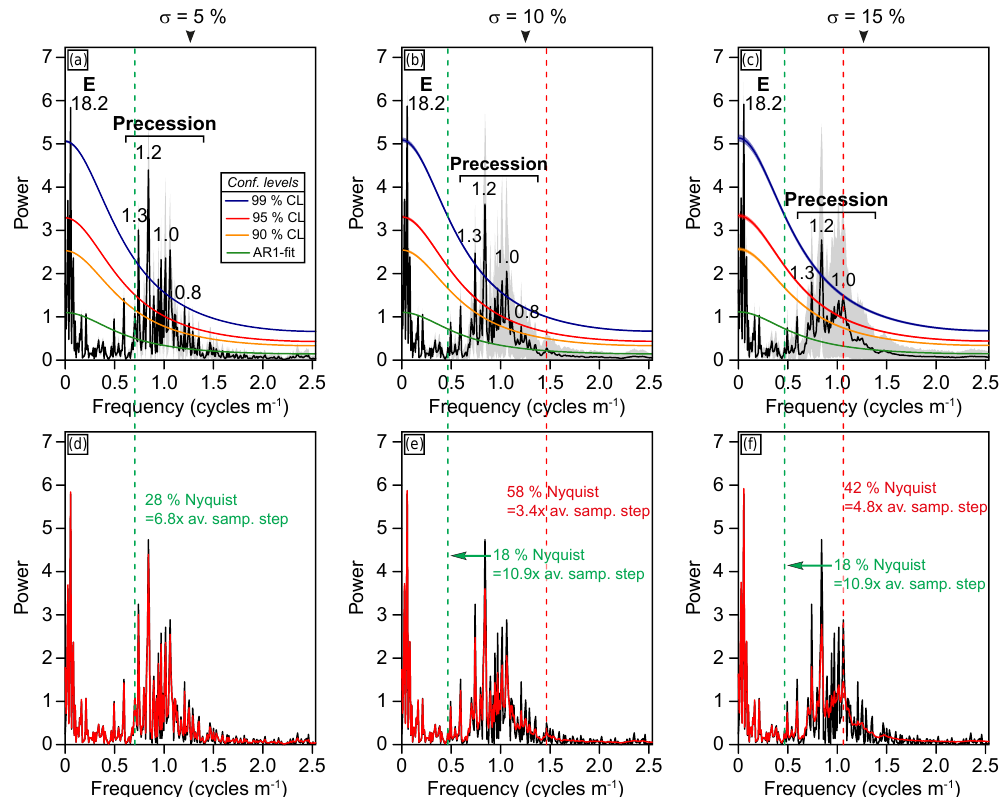
Figure 9. Effect of the gamma-law randomisation of the sample distances on the REDFIT spectrum of the La Charce series. Panels a to c : REDFIT spectra with a level of stratigraphic uncertainty fixed to 5, 10 and 15% of the average sample distance of the series. The grey area represents the interval covering 95% of the simulations. The average confidence levels are reported on the spectra with their respective areas covering 95% of the simulations. Main significant periods are indicated in metres with, in bold, their corresponding orbital cycles. E: 405kyr eccentricity. Panels d to f : superposition of the REDFIT spectra before randomisation (in black) and the average spectrum after the 1000 simulations (in red). The red dashed lines indicate the lowest frequency above which the spectrum is completely smoothed, so that no other frequency can be identified. The green dashed lines represent the highest frequency below which the spectrum of the series before randomisation appears practically identical to the spectrum after